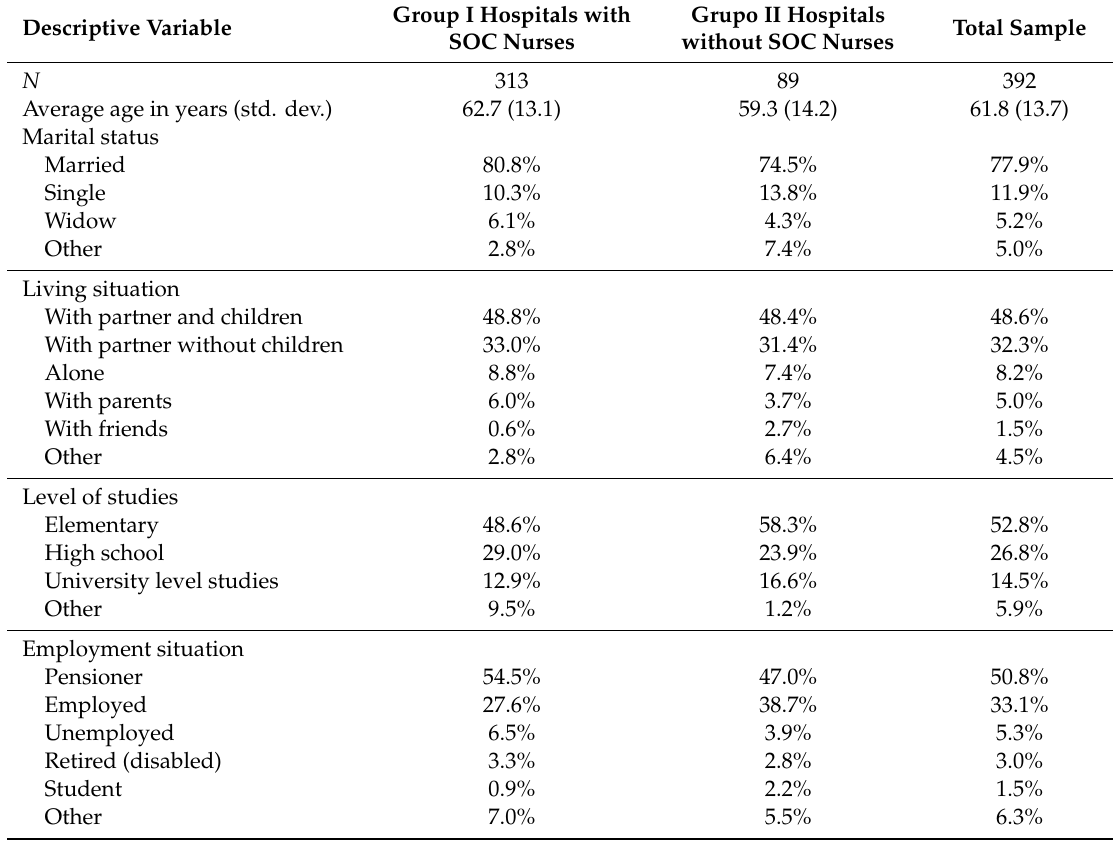
Table 1. Socio-demographic characteristics in the sample. SOC: specialist in ostomy